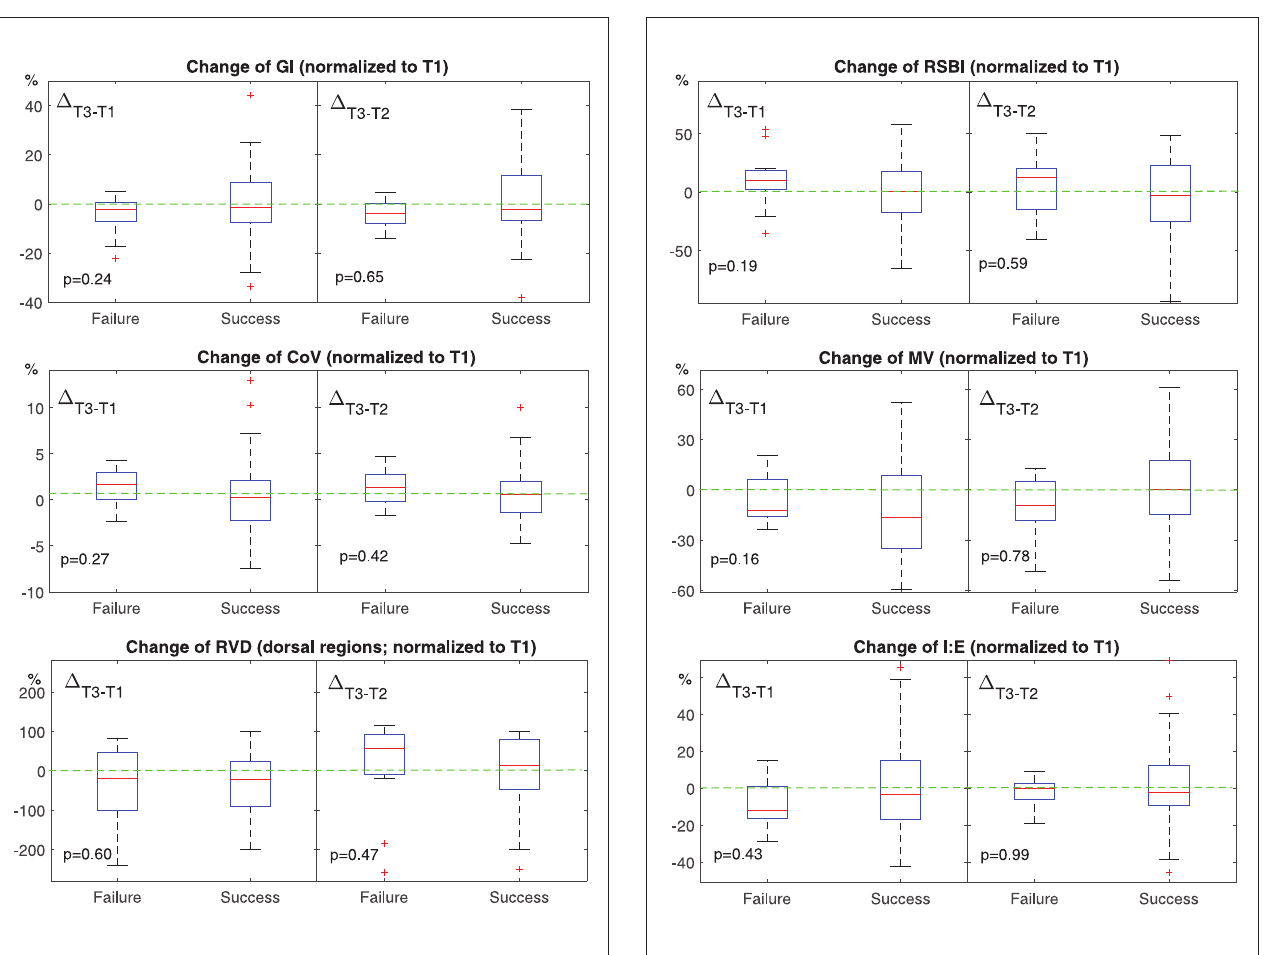
FIGURE 2 | Change of conventional EIT-based parameters at different time points. T1, before HFNC; T2, 30min after HFNC started; T3, 1h after HFNC started. All values were normalized to that at T1. The boxes mark the quartiles with median marked red, while the whiskers extend from the box out to the most extreme data value within 1.5* the interquartile range of the sample. The red crosses are outliers. Green dashed lines marked the value of 0. GI, the global inhomogeneity index. Lower than 0 means the ventilation becomes more homogeneous. CoV, the center of ventilation. Higher than 0 means that the ventilation distribution moves toward dorsal regions. RVD, regional ventilation delay. Higher than 0 means the delay is getting worse.